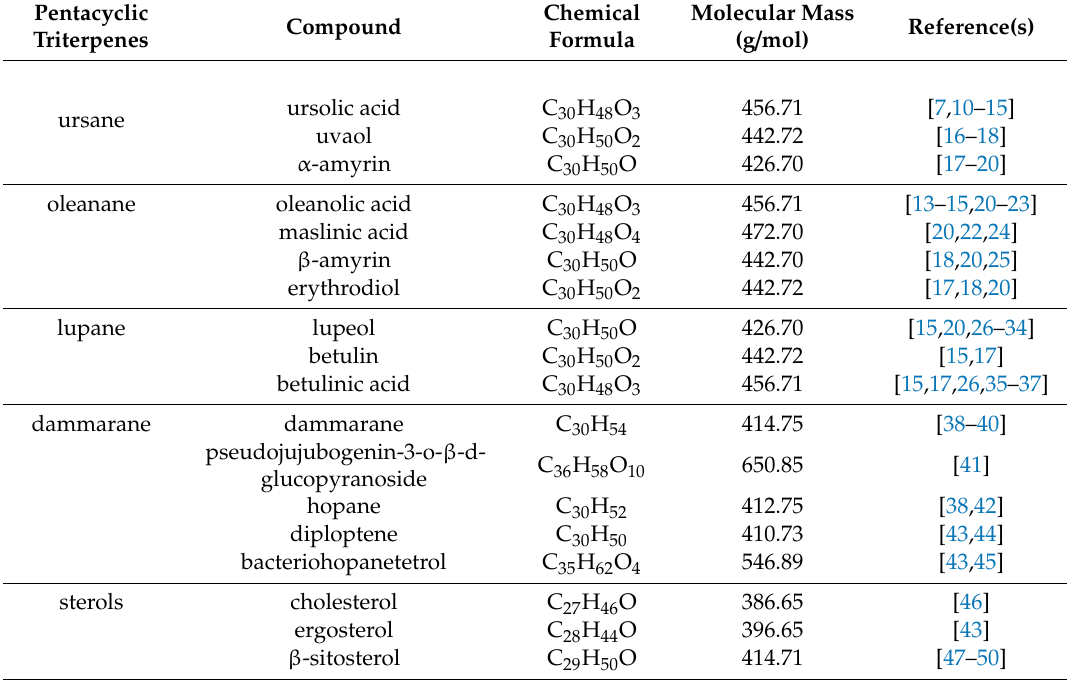
Table 1. Pentacyclic triterpene compounds from plant sources with their chemical